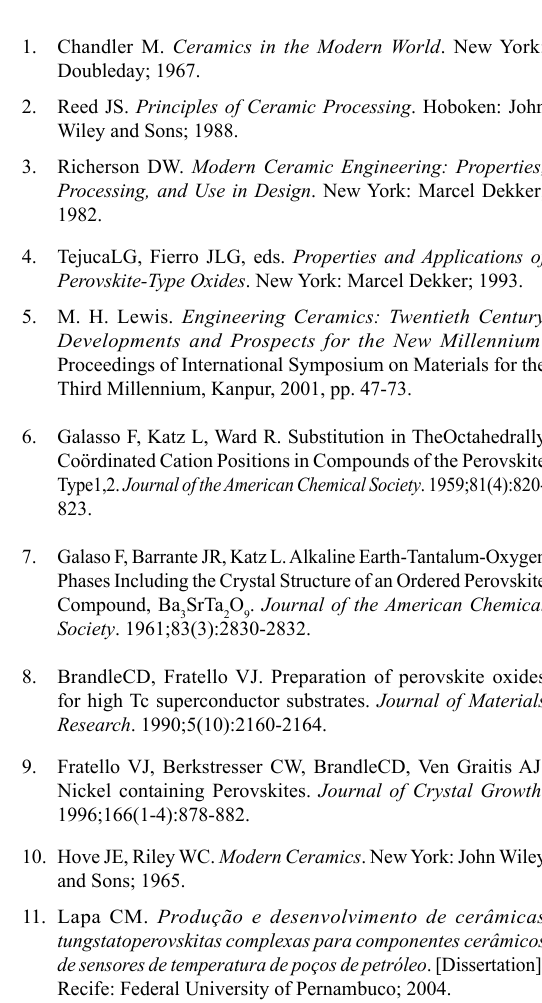
AlNbO ceramics before and 2 6